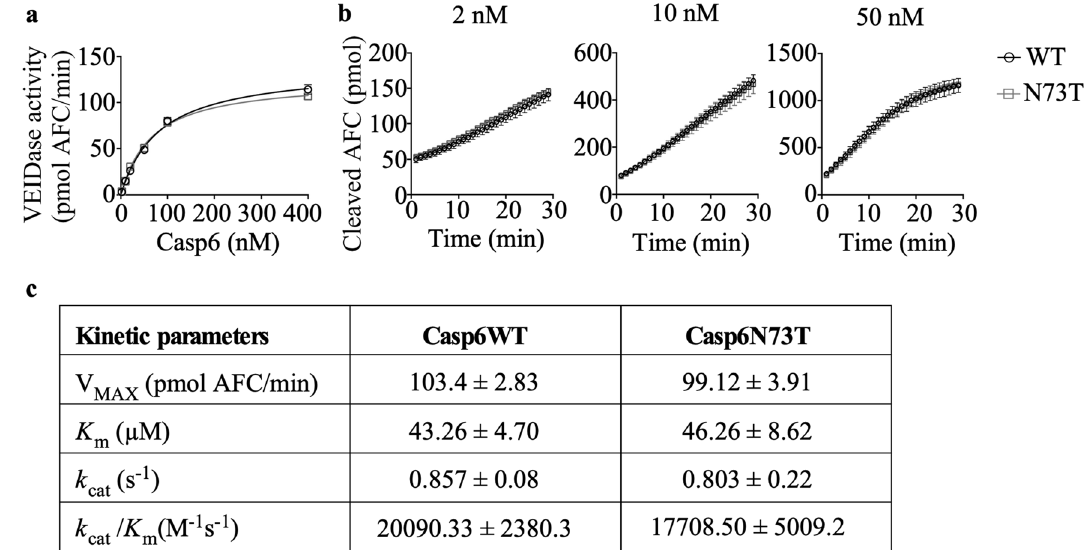
Figure 3. Casp6WT and Casp6N73T enzymatic processing of Ac-VEID-AFC. ( a ) VEIDase activity of Casp6WT or Casp6N73T at 2, 10, 20, 50, 100, or 400 nM on 20 µM Ac-VEID-AFC. ( b ) Cleaved Ac-VEID-AFC generated with time by Casp6WT or Casp6N73T at 2, 10, or 50 nM on 20 µM Ac-VEID-AFC. Data represents mean and s.e.m. from 3 independent experiments. No statistical differences were found by two-way ANOVA ( a ) or repeated measures two-way ANOVA ( b ). ( c) V MAX , K m , k cat , and k cat /K m values for Casp6WT and Casp6N73T. Data represents mean and SD from 3 independent